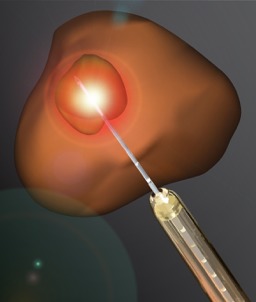
Precise sampling of a ROI [25].